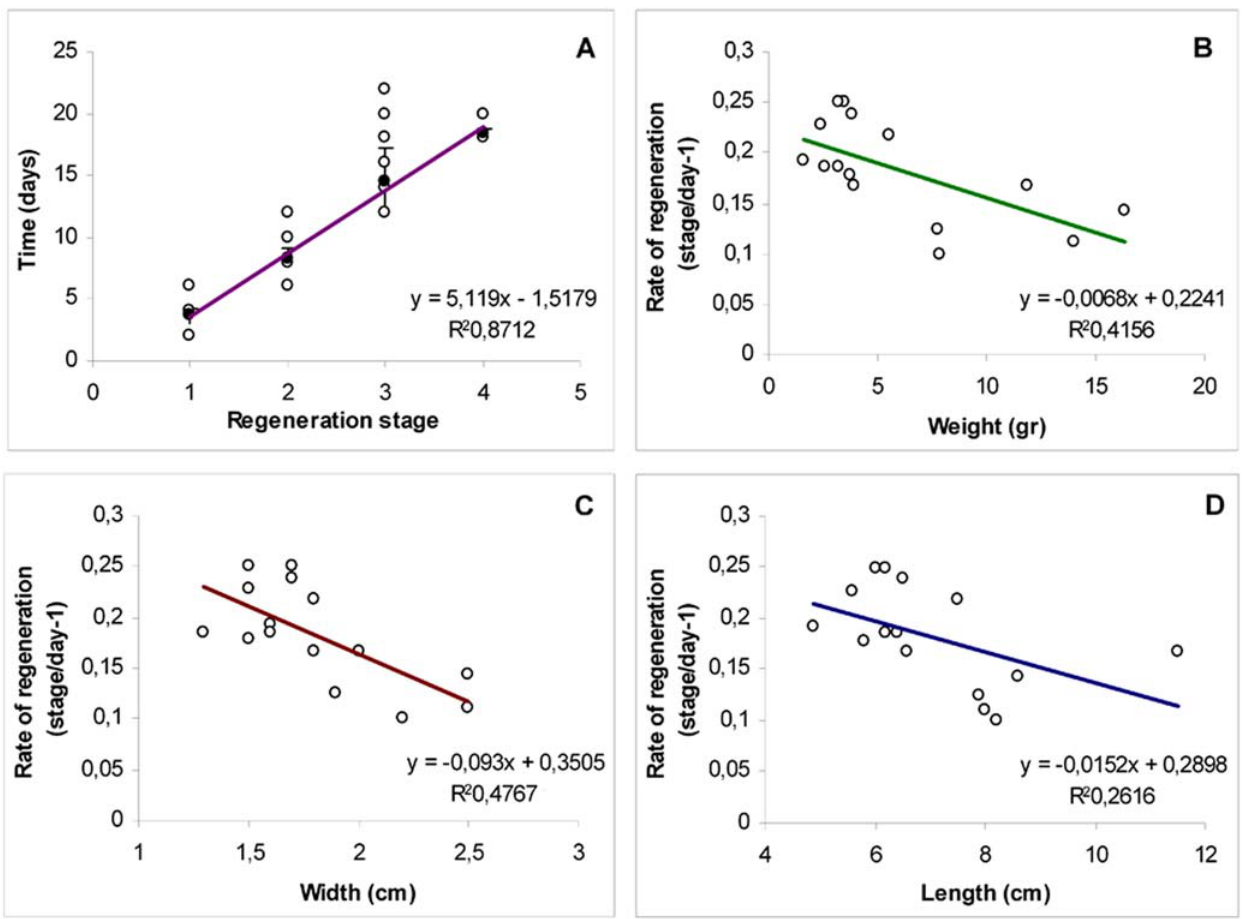
Figure 4. Regeneration is inversely proportional to size. A Relationship between time (in days) and regeneration stage. Stages are defined such that they have a similar duration. Mean stage duration (or regeneration rate) can then be calculated as the correlation coefficient for the linear regression. B–D Significant (p , 0.01) linear relationship between different morphometric parameters and rate of regeneration (stages/day). B , Length (in cm); C , width (in cm); D , weight